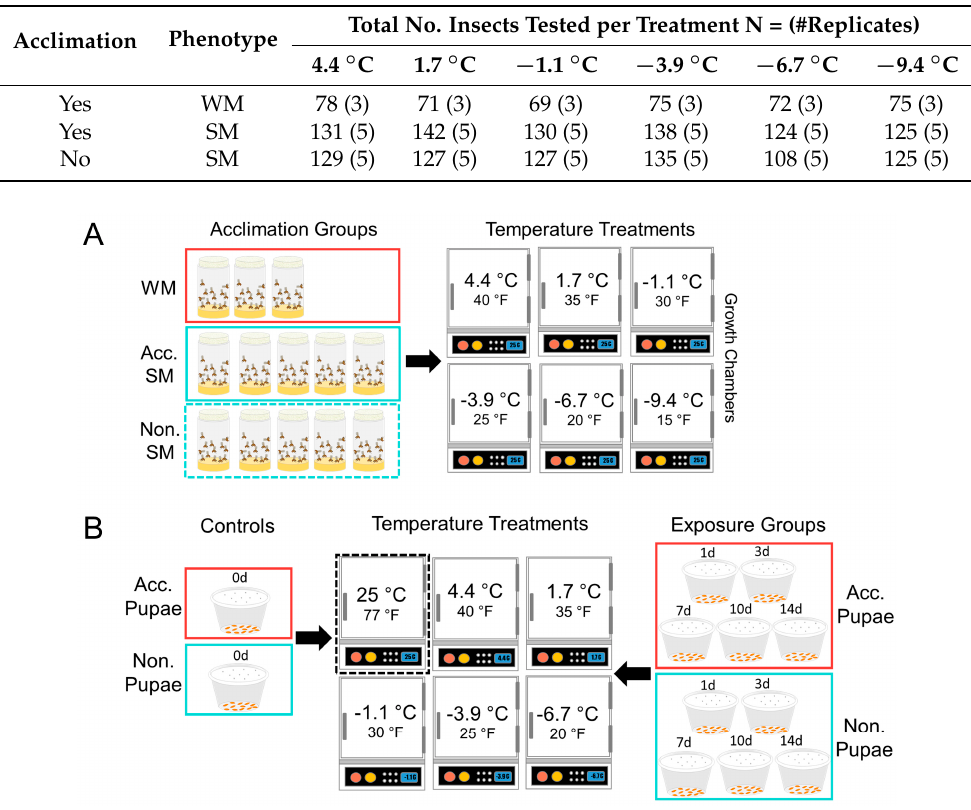
Figure 1. Experimental design of the adult ( A ) and pupal ( B ) static susceptibility tests. Group labels: “WM” refers to developmentally acclimated WM flies, “Acc. SM” refers to acclimated SM flies, and “Non. SM” refers to non-acclimated SM flies.